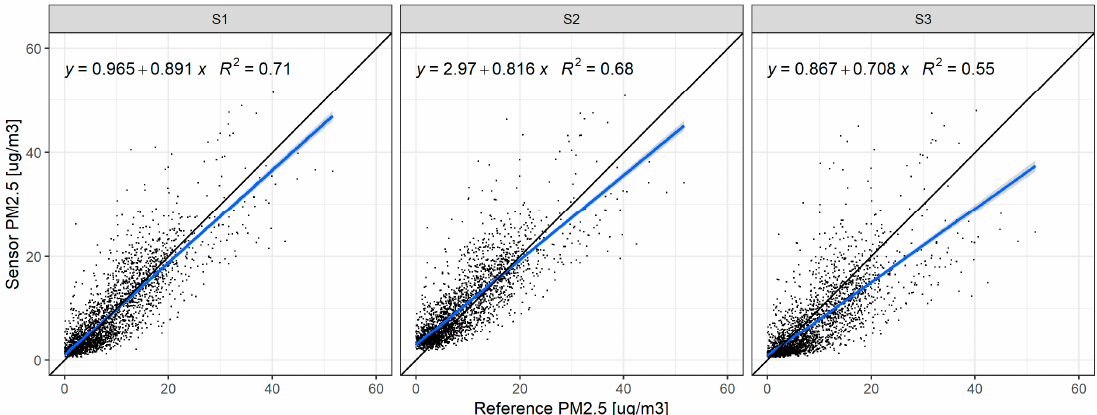
Figure 6. Linear regression for 1-hour average PM 2.5 values from the three SDS011 sensors versus the PM 2.5 data from the air quality monitoring station for the entire study period. Table 2. Summary statistics for Figure 6 (SD: Standard Deviation; MAE: Mean Absolute Error; RMSE: Root-Mean-Square Error; Mean reference value = 9.25 µ g/m 3 ). Variable